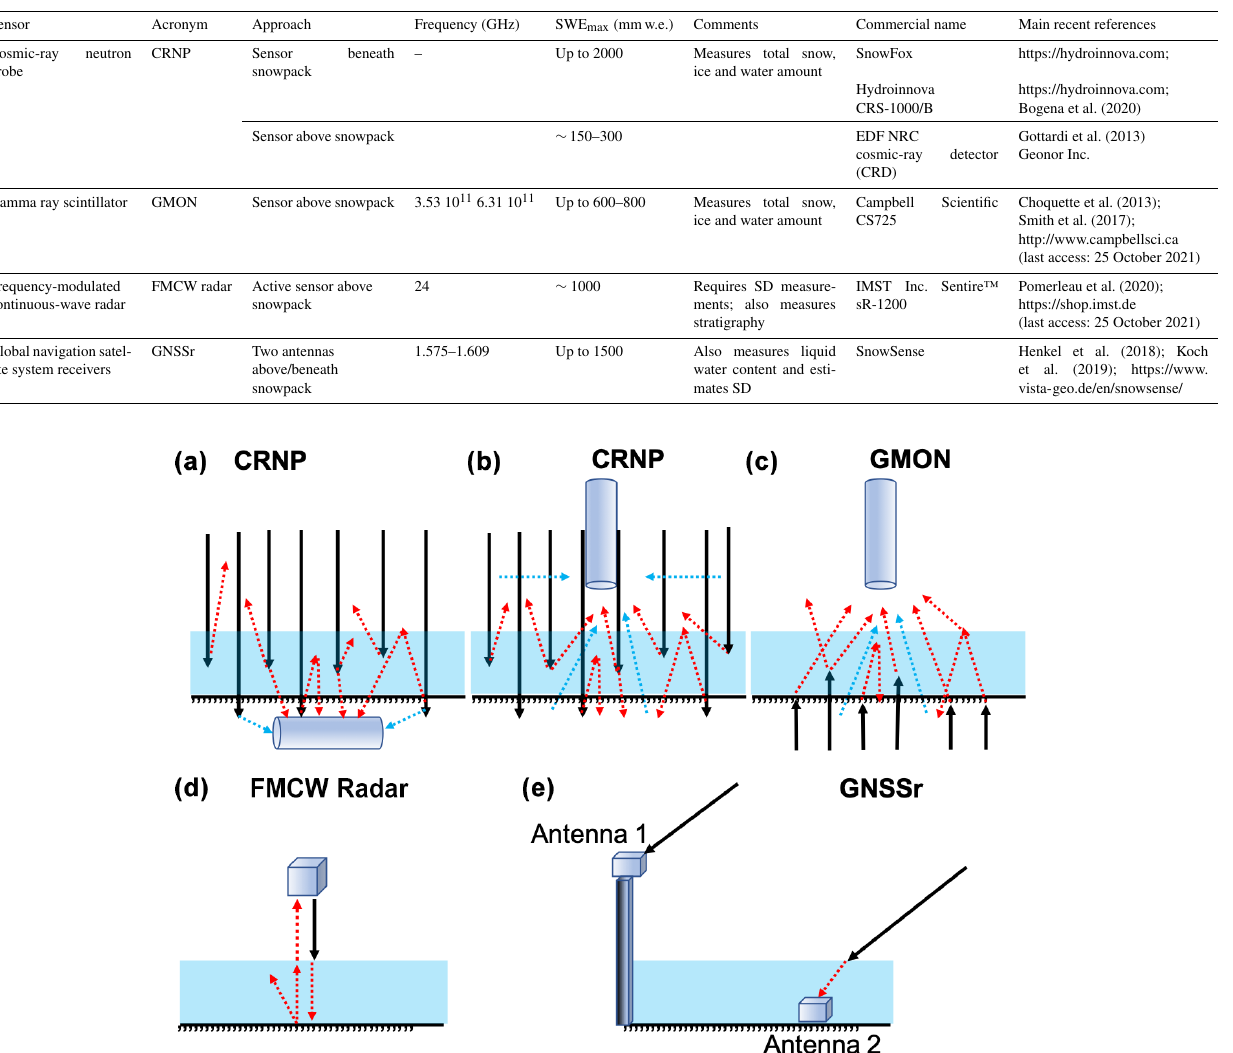
Figure 1. Diagram of radiation paths for the five approaches (see Table 1). In all figures, black arrows correspond to natural (a, b, c) or emitted (d, e) signals, and dotted red arrows correspond to rays interacting with snow (the lower the signal reaching the sensor is, the higher the SWE is). The footprint of the sensor is defined by the area from which emanates the measured radiation having interacted with the snow. (a) Cosmic-ray neutron probe (CRNP) below the snow, buried in the ground. In this case, black arrows are ambient neutrons generated primarily by interactions of secondary cosmic-ray neutrons with terrestrial and atmospheric nuclei. Dotted red arrows are neutrons interacting with snow, which decrease when SWE increases. Dotted blue arrows are neutrons interacting with soil moisture. (b) CRNP above the snow, looking downward. Same as (a) for the arrow meanings, but dotted blue arrows are neutrons interacting with soil and atmospheric moisture. (c) Gamma ray monitoring (GMON) sensor. Same as (a) for the arrow meanings. (d) Frequency-modulated continuous-wave radar (FMCW radar) looking downward above the snow. The black arrows are the radar-emitted wave at 24GHz. (e) Global navigation satellite system (GNSS) receivers. The two antennas receive signals emitted by all of the GNSS satellites in the antennas’ field of view and at all incidence angles: only one incident ray (black arrow) at one angle is shown. According to the inversion algorithm, different rays that interact with the snow (dotted red arrows) are used. For the SnowSense system, independent measurements at antenna 1 and antenna 2 are